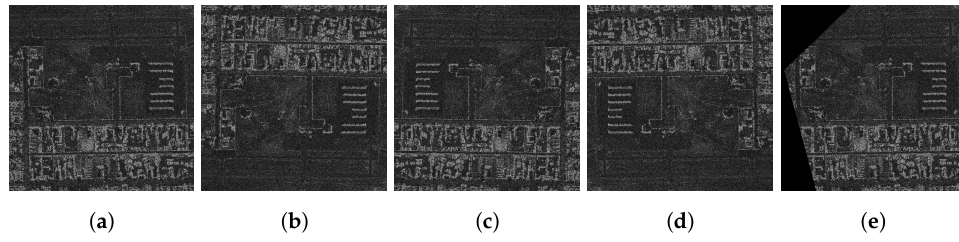
Figure 2. Operations of mirroring and trimming of a SAR scan. Image ( a ) presents the original image for mirroring, ( b – d ) are mirrored, ( e ) presents simple image trimming for data augmentation.